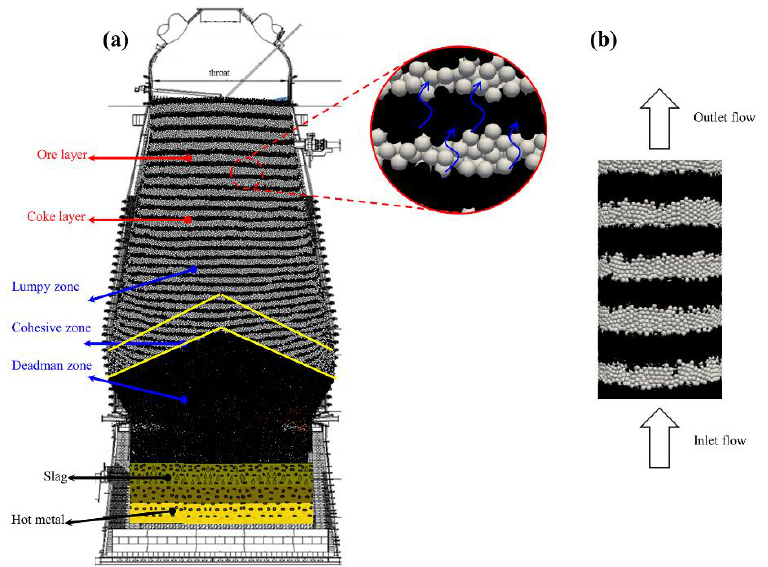
Figure 1. An illustration for heterogeneous alternating layer packed beds: ( a ) Blast furnace with a detailed lumpy zone; ( b ) a simplified model of a HAL packed bed.